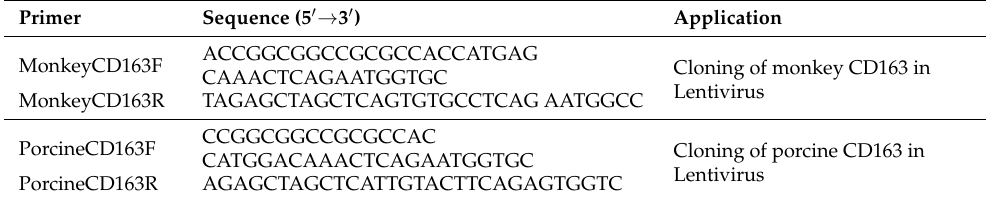
Table 3. Oligonucleotide primers used in the construction of lentivirus expressing CD163 gene.